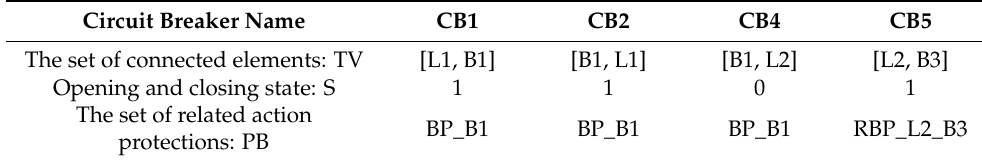
Table 3. Instance representation of CB1, CB2, CB4 and CB5.